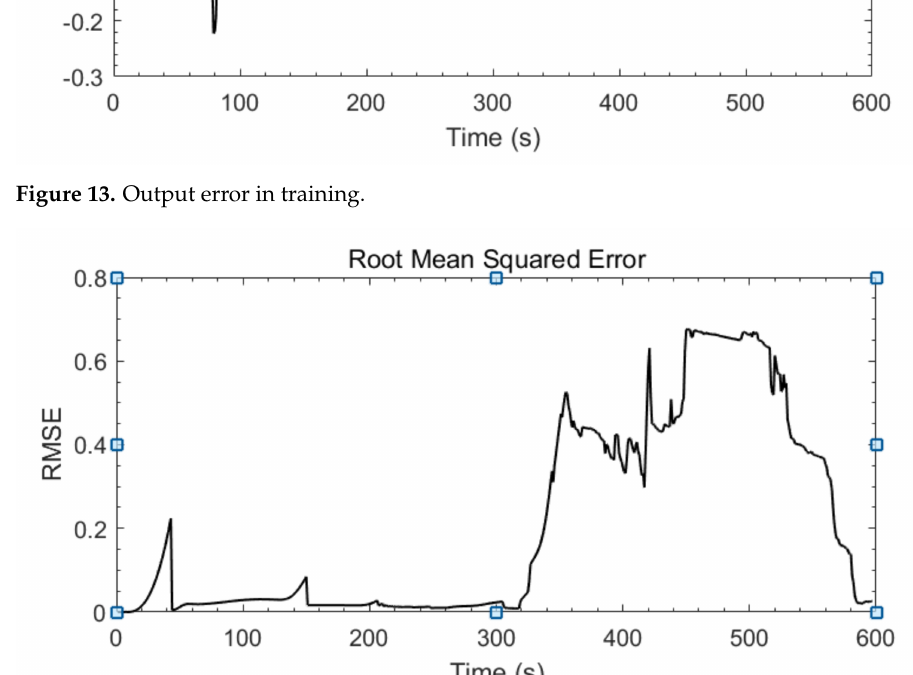
Figure 14. Root mean squared error in